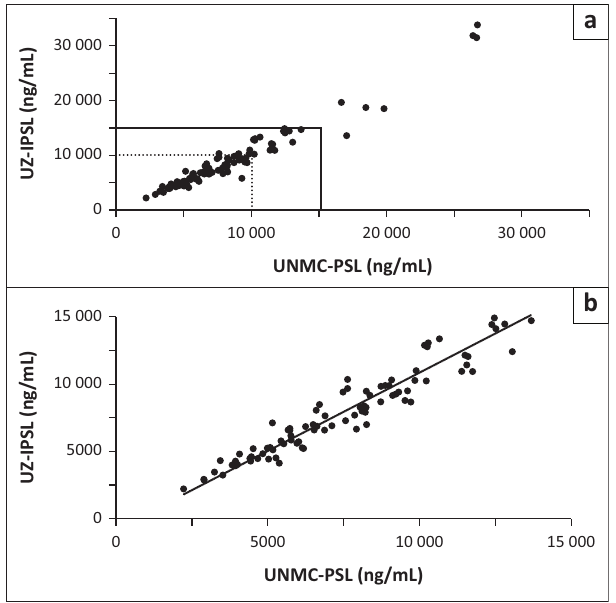
FIGURE 2: Differences in nevirapine samples ( n = 87) assayed at UNMC-PSL (Omaha, Nebraska, United States, October 2017) and UZ-IPSL (Harare, Zimbabwe, May 2018). (a) Bland-Altman difference plot indicating proportionally higher difference at high concentrations (mean difference = −430). (b) Bland- Altman percentage difference on normalisation by concentration, correlation not significant (mean % deviation = −4.49). Shaded areas present confidence interval limits for mean (green shade) and agreement limits (red shade).